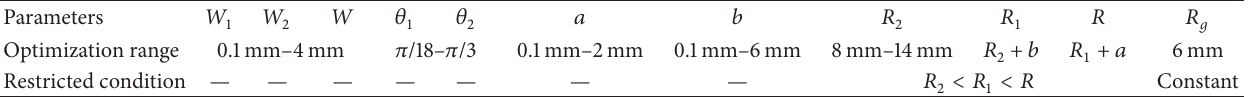
Table 1: Range setup of optimized